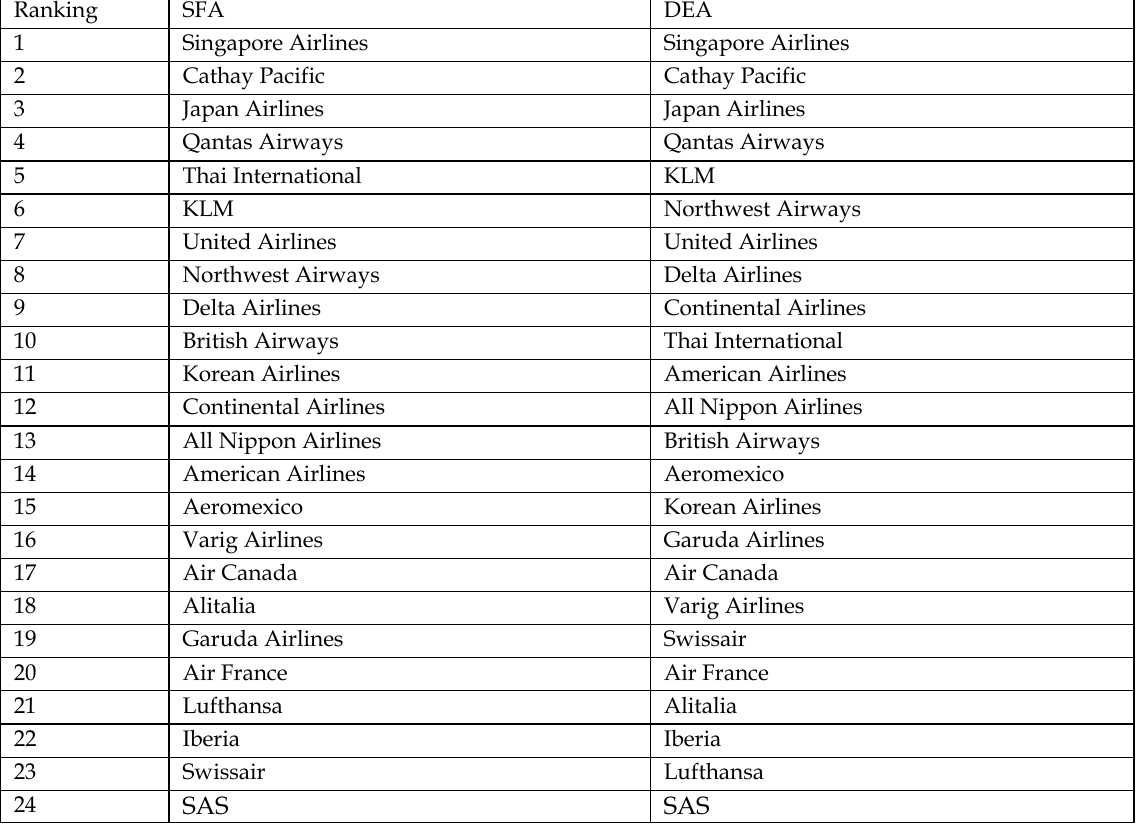
Table 3. Airlines’ Ranking